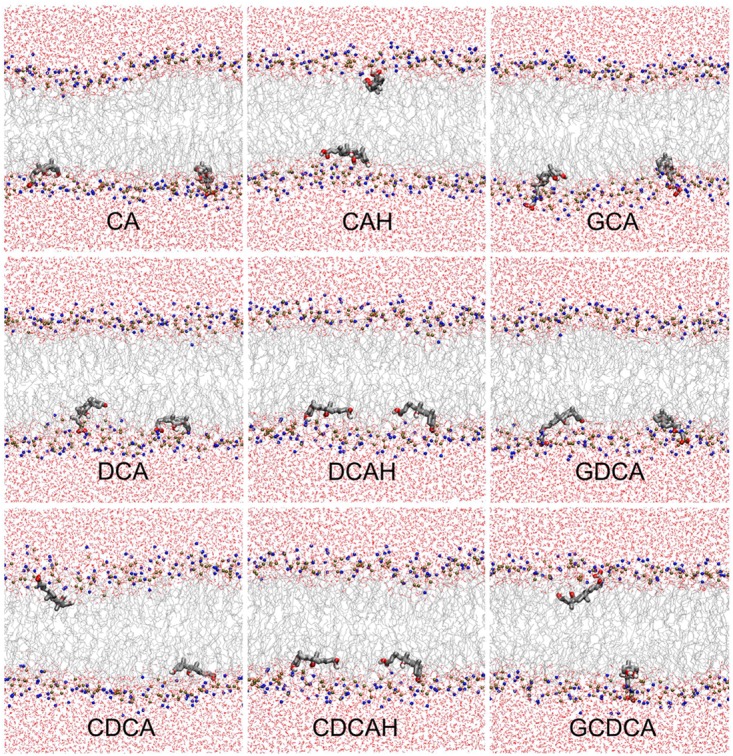
Final snapshots of the simulations with initial BS location in the center of the bilayer. BS molecules are depicted in licorice, while POPC and water molecules are depicted in line style. Atom colors are gray, red, brown, blue, and white, for C, O, P, N, and H, respectively.